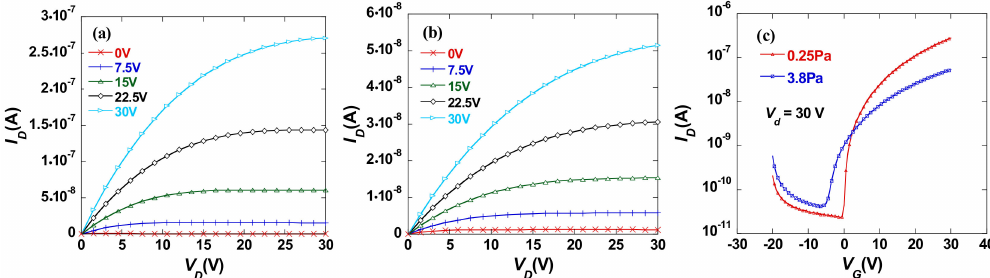
Figure 2. Output curves for device A ( a ) and device B ( b ). ( c ) Transfer curves for device A and device B.